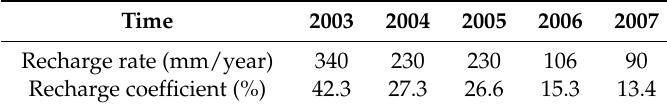
Table 5. Recharge rate of LC site from 2003 to 2007 at the LC